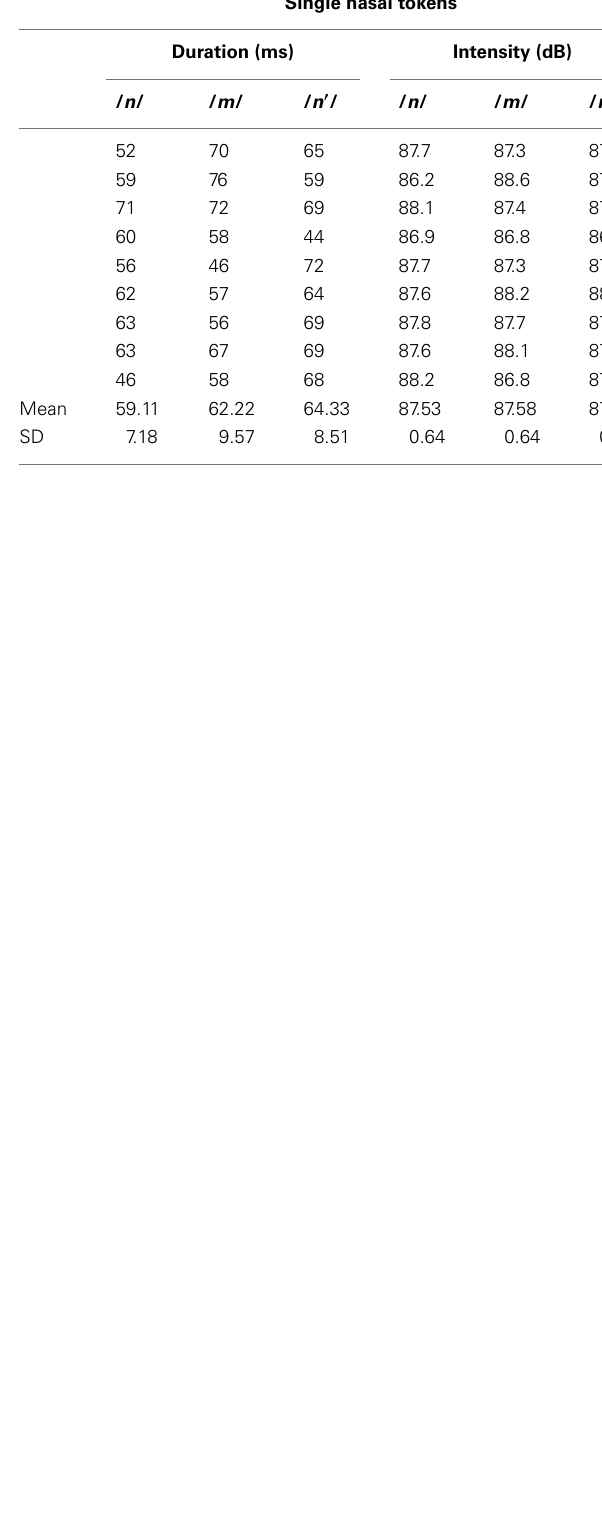
TableA1 |The sentences used for recording.